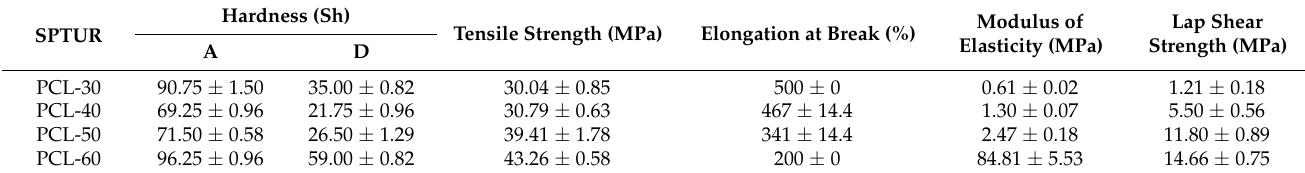
Table 6. Hardness and mechanical properties of SPTURs.